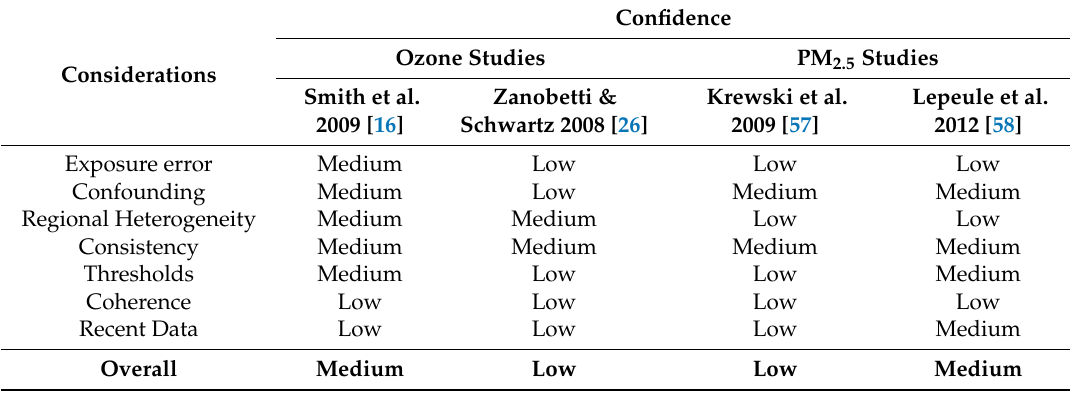
Table 1. Confidence in Short-Term Ozone Mortality Studies and Long-Term PM 2.5 Mortality Studies Used by the EPA to Derive Benefits from Decreasing the Ozone